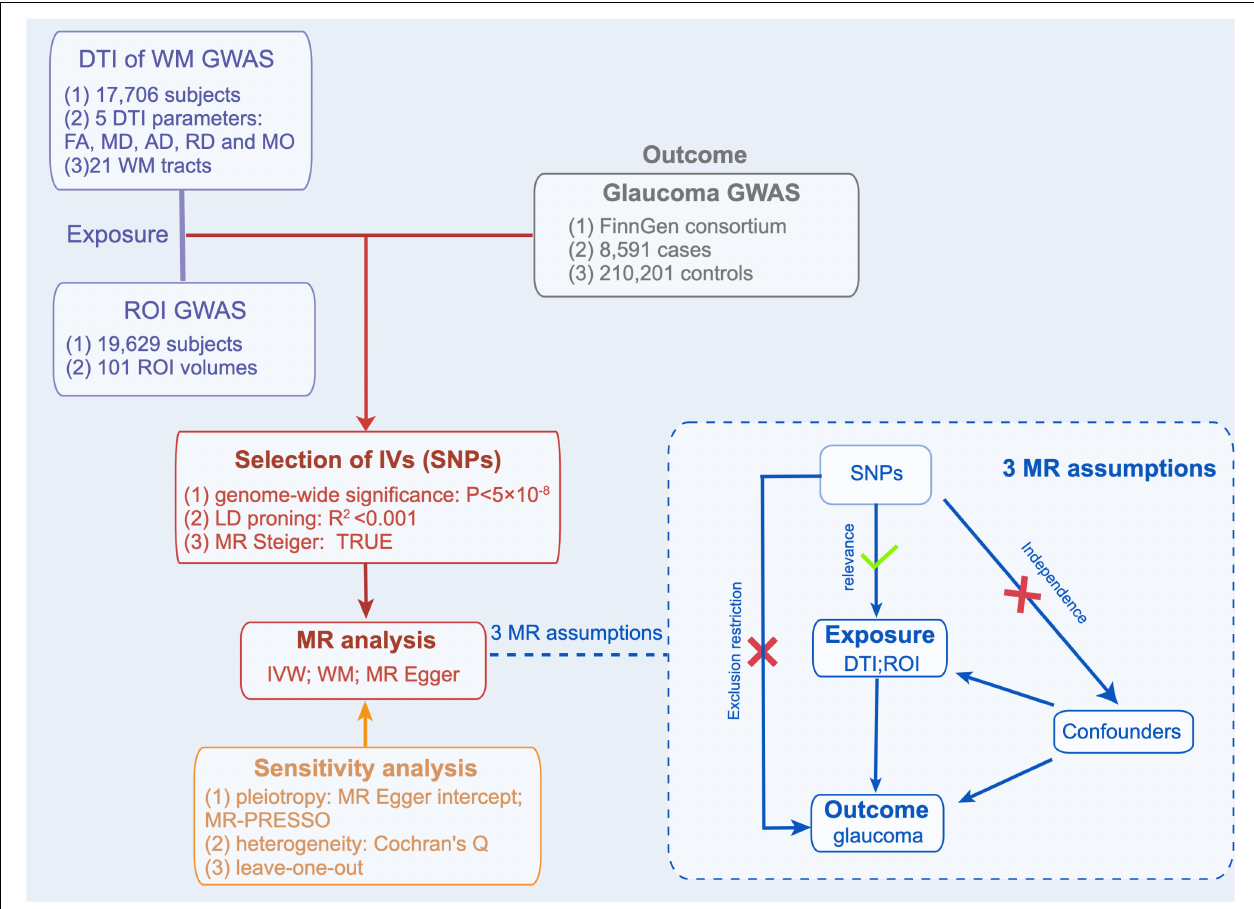
FIGURE 1 | Mendelian Randomization Analysis Overview. Overview of Mendelian randomization analyses and major assumptions. DTI, indicates diffusion tensor imaging; WM, white matter; ROI, region of interest; FA, fractional anisotropy; MD, mean diffusivity; AD, axial diffusivity; RD, radial diffusivity; MO, mode of